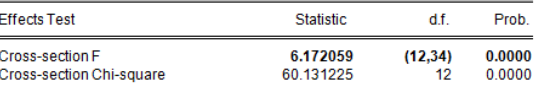
Source: Eviews 7